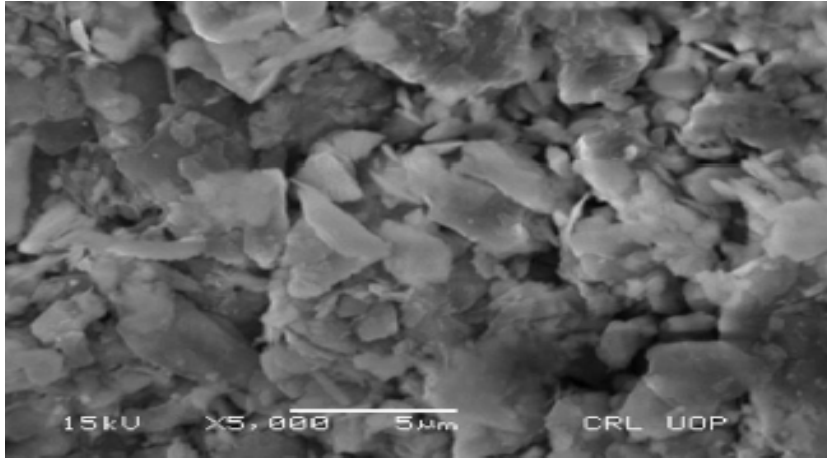
Figure 1. SEM of Bentonite Clay, reprinted from permission of Elsevier [44].